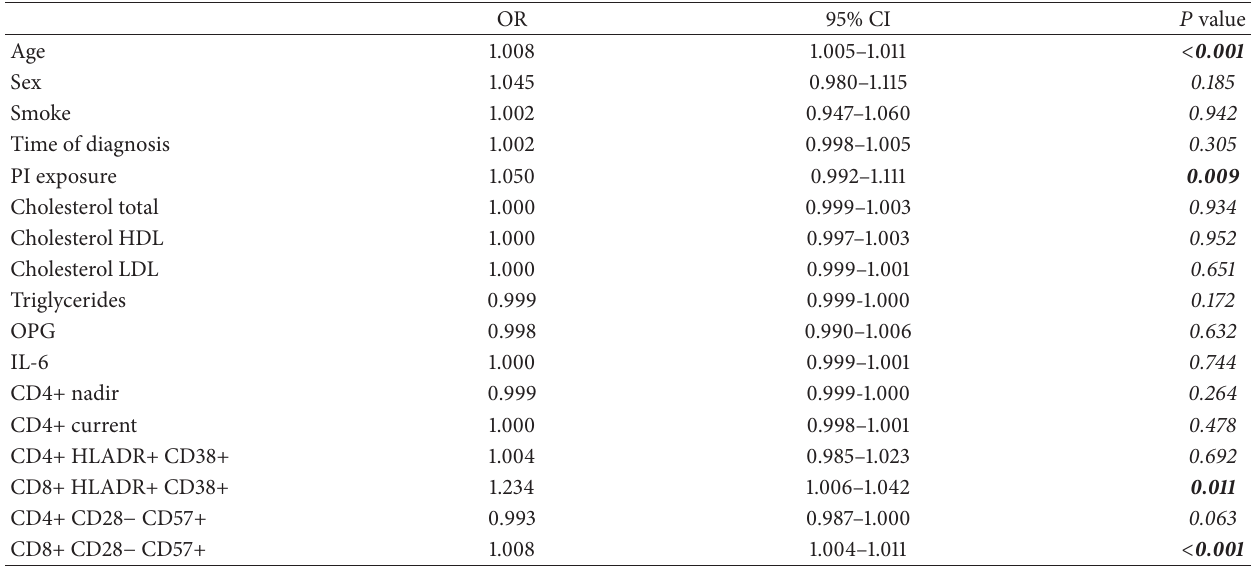
Table 2: Multivariate